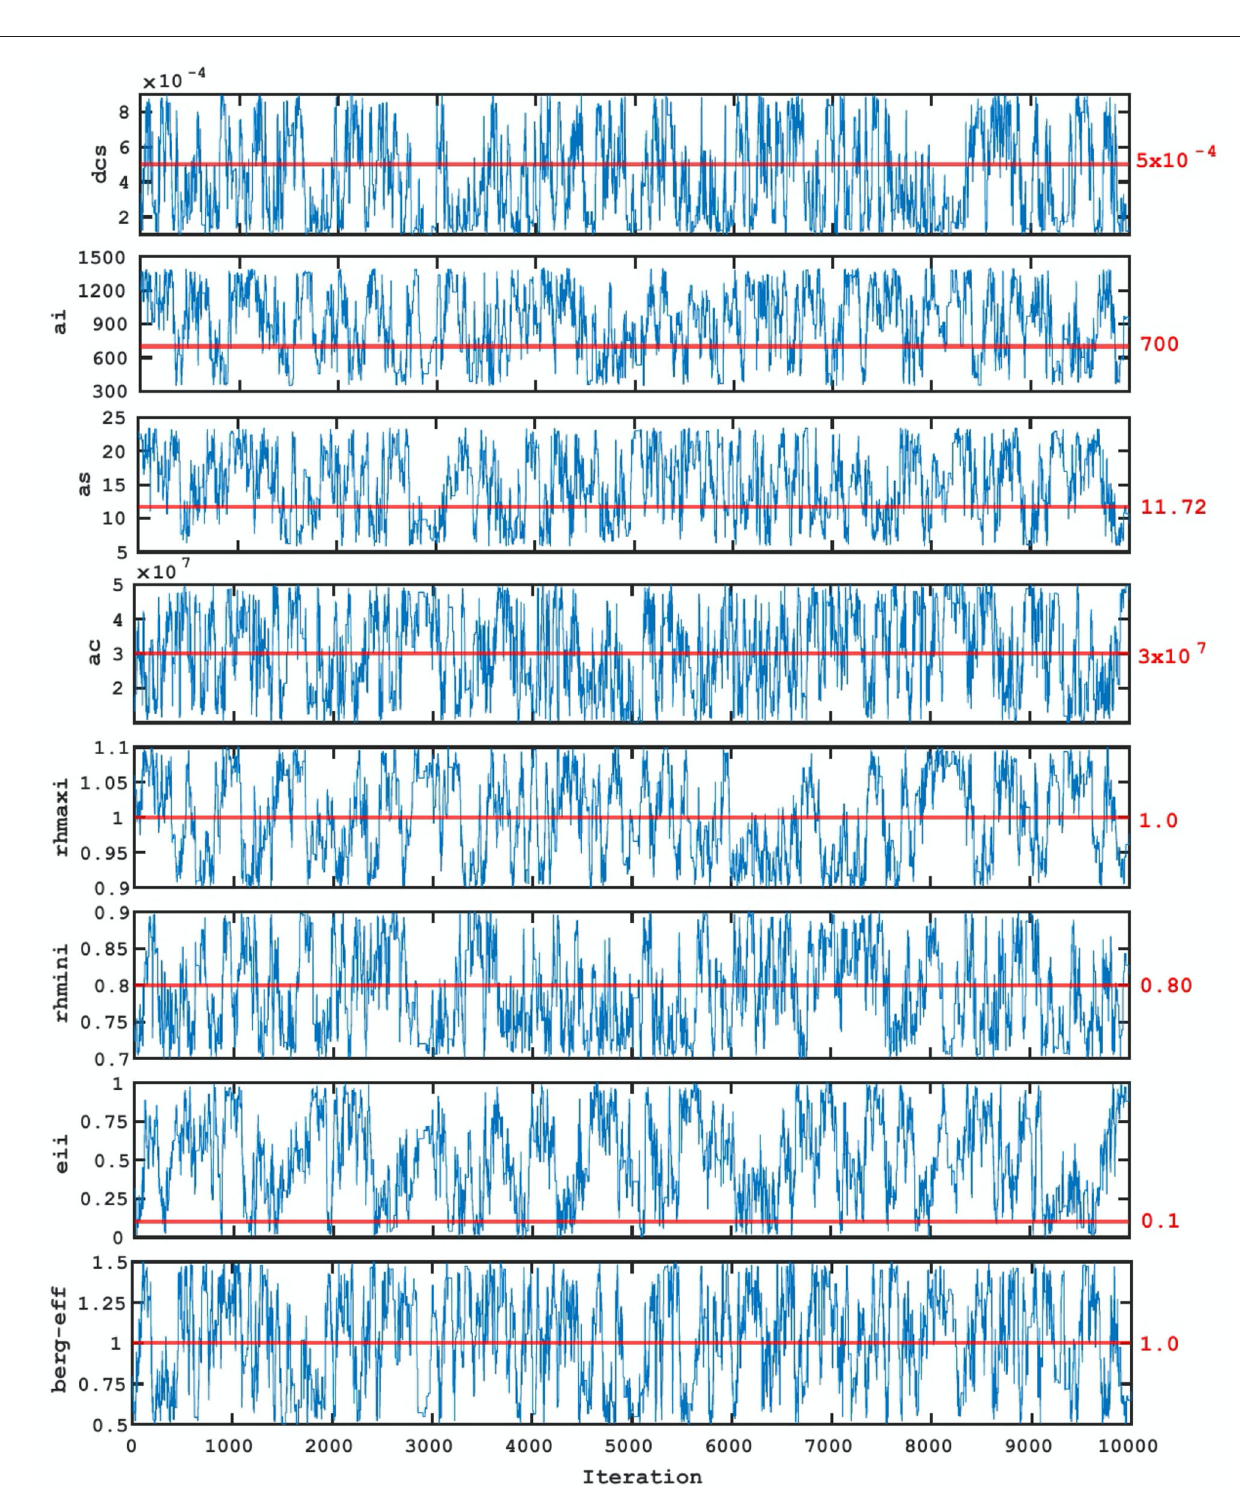
Frontiers in Climate |